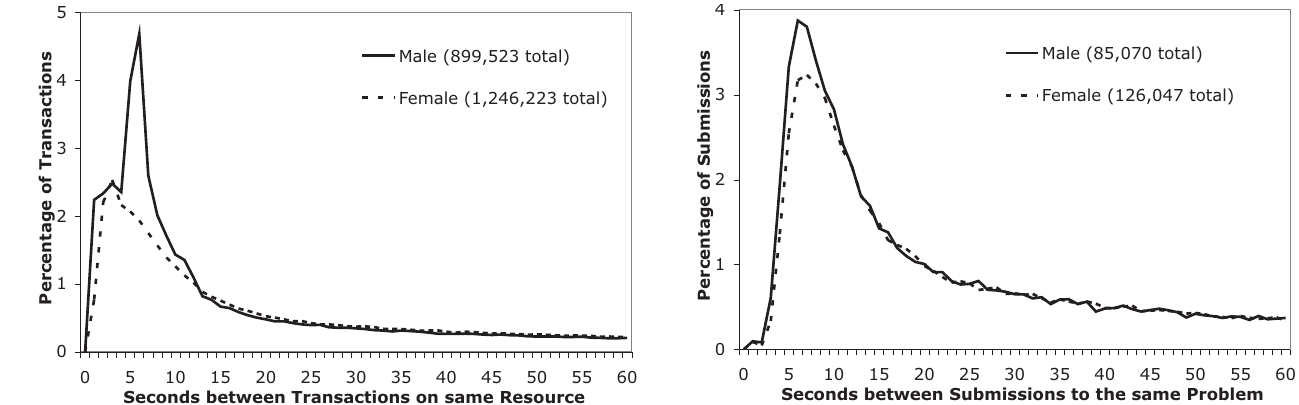
FIG. 6. Distribution of times between subsequent submissions to the same problem within less than 1 min of